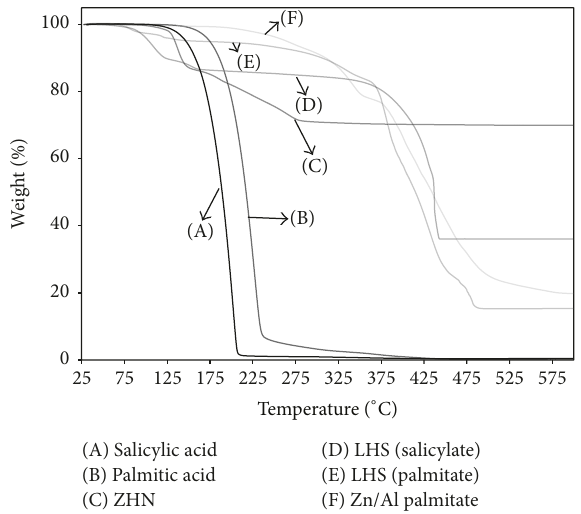
Figure 4: TGA curves of intercalating anion precursors and fillers